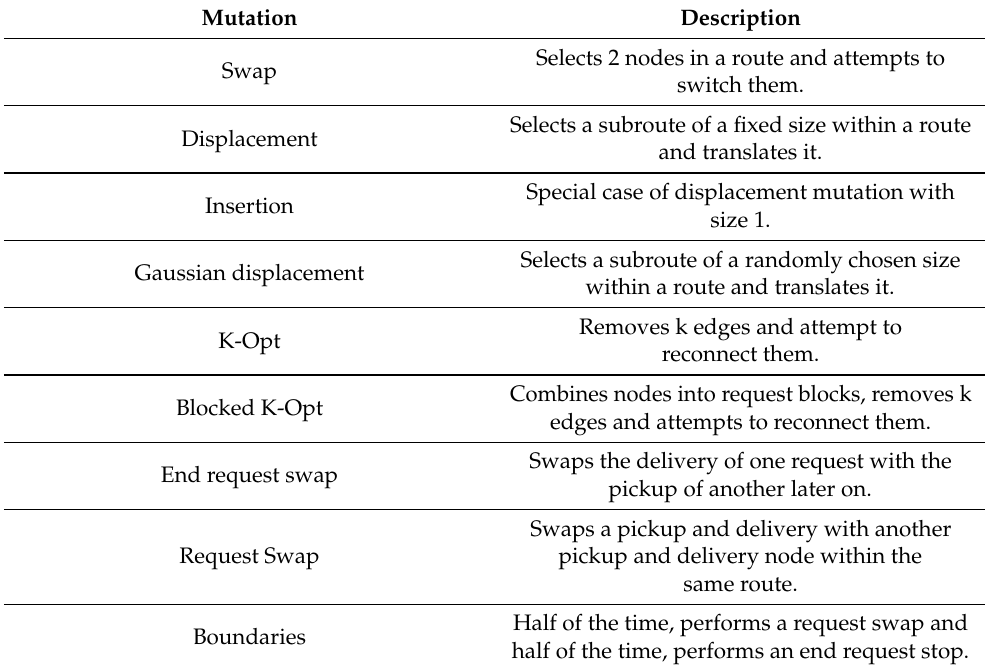
Table 2. Example of a route that has been